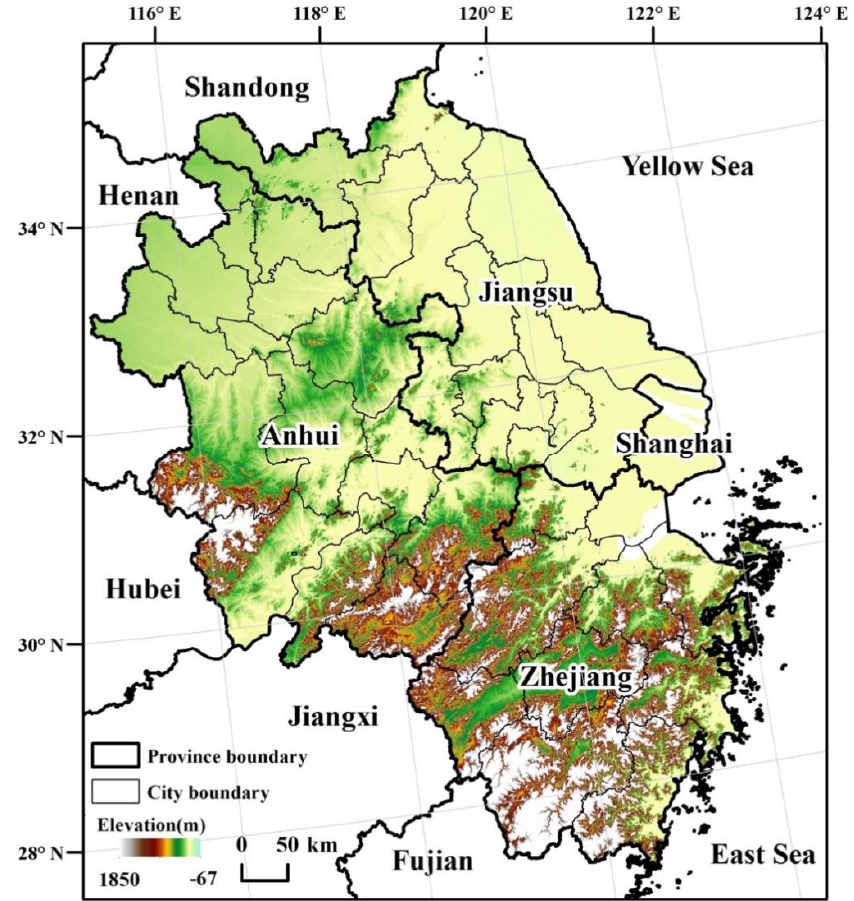
Figure 2. Geographic location of the Yangtze River Delta in China.